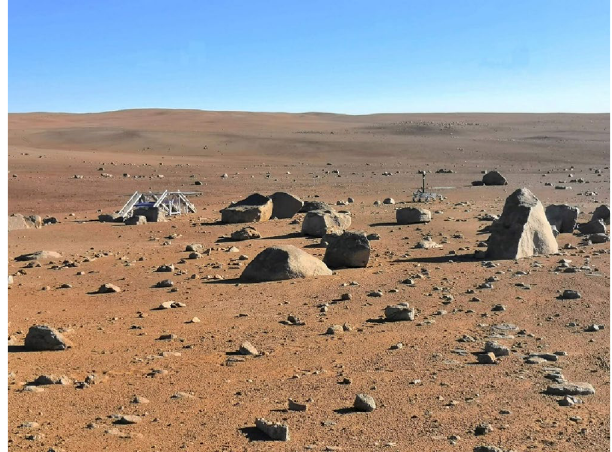
Figure 1. Image of the desertic area selected for the ExoFiT trial (Atacama Desert). The ExoMars rover and landing platform emulators can be